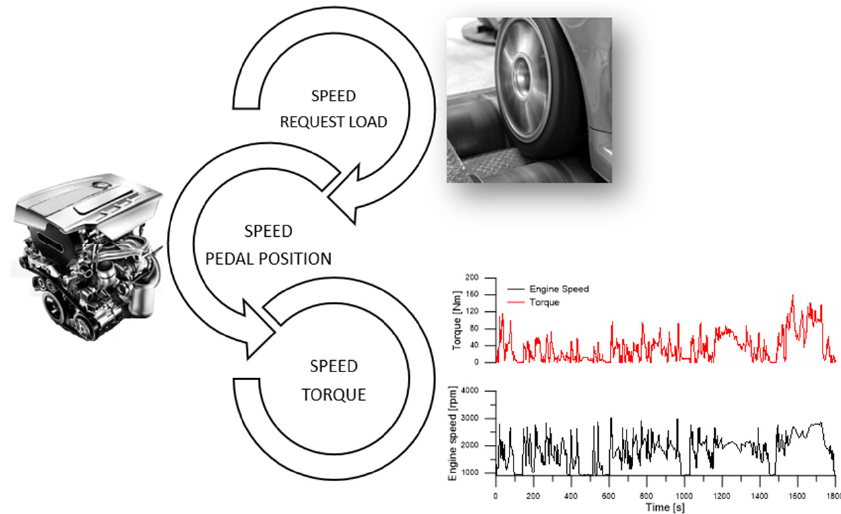
Figure 2. Schematic of the reproduction of the WLTC at the ETB.